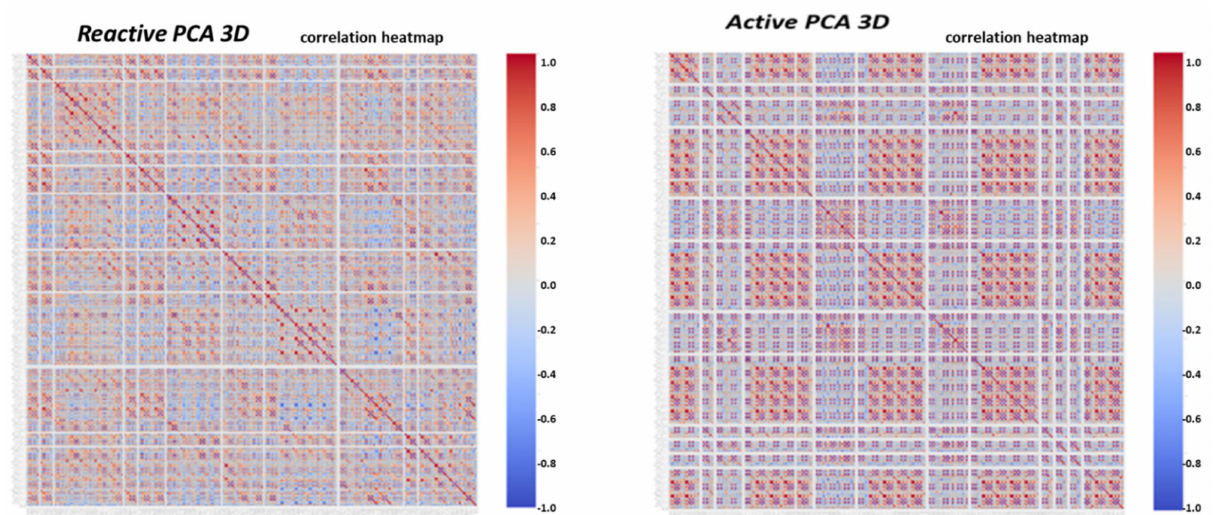
Figure 16. Active vs. reactive—all features vs. fraud, Pearson correlation heatmap. An active map is hotter than a reactive map and is more correlated with fraud. There is no intention of noticing inner variances inside the 2D image. Simple notification of stronger